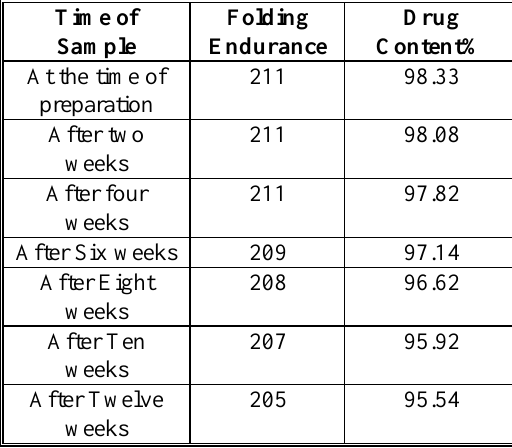
Table 5. Stability data of optimized microneedle patch (F10 3% T80) stored at 40 ± 0.58 °C and 75± 5% relative humidity